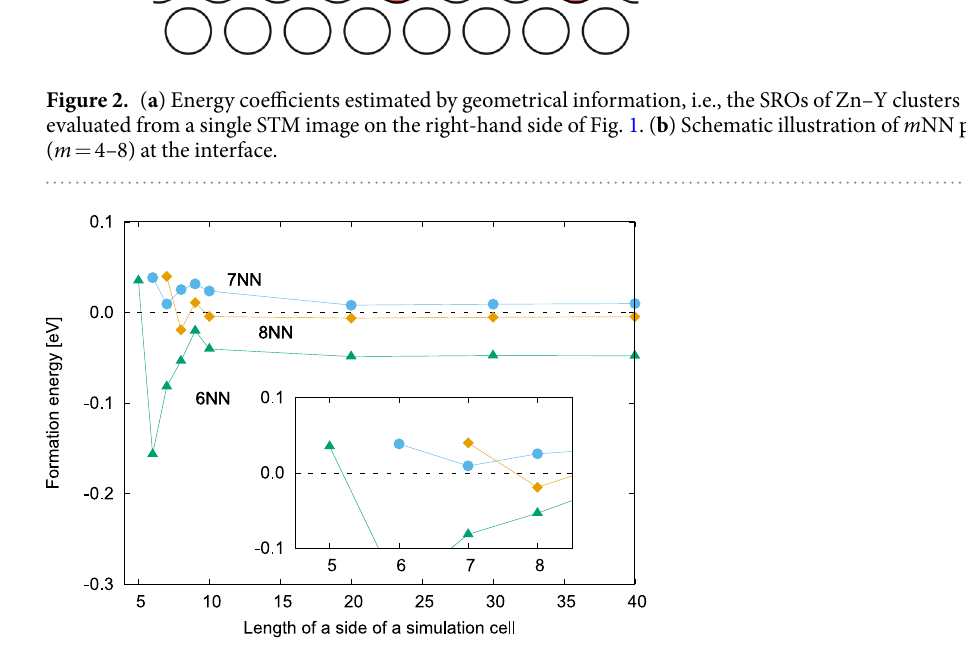
Figure 3. Pair-formation energy of a single m NN cluster–cluster pair, as defined by Eq. (1), for each L × L two-dimensional triangular lattice. The inset emphasizes the behavior of pair-formation energy in L = 5–8 simulation